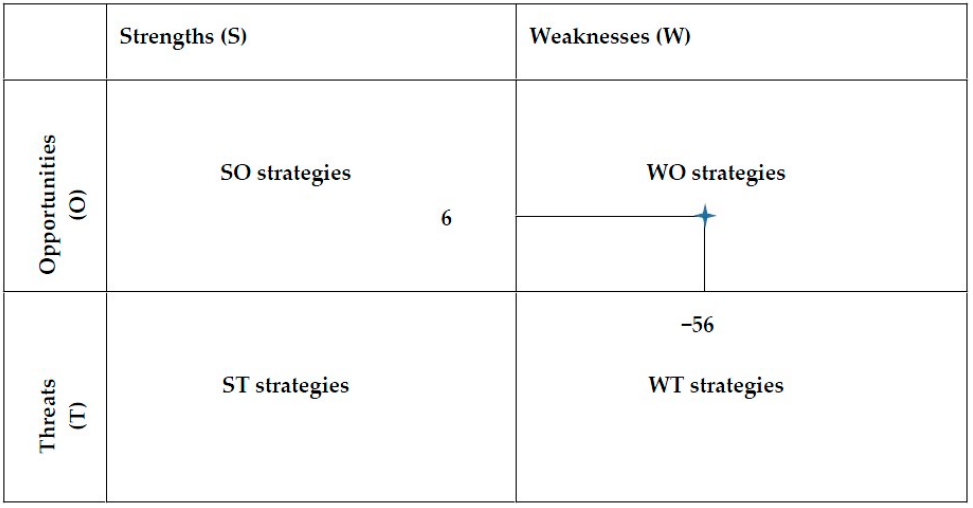
Figure 3. TOWS matrix of forestry contractor firms.